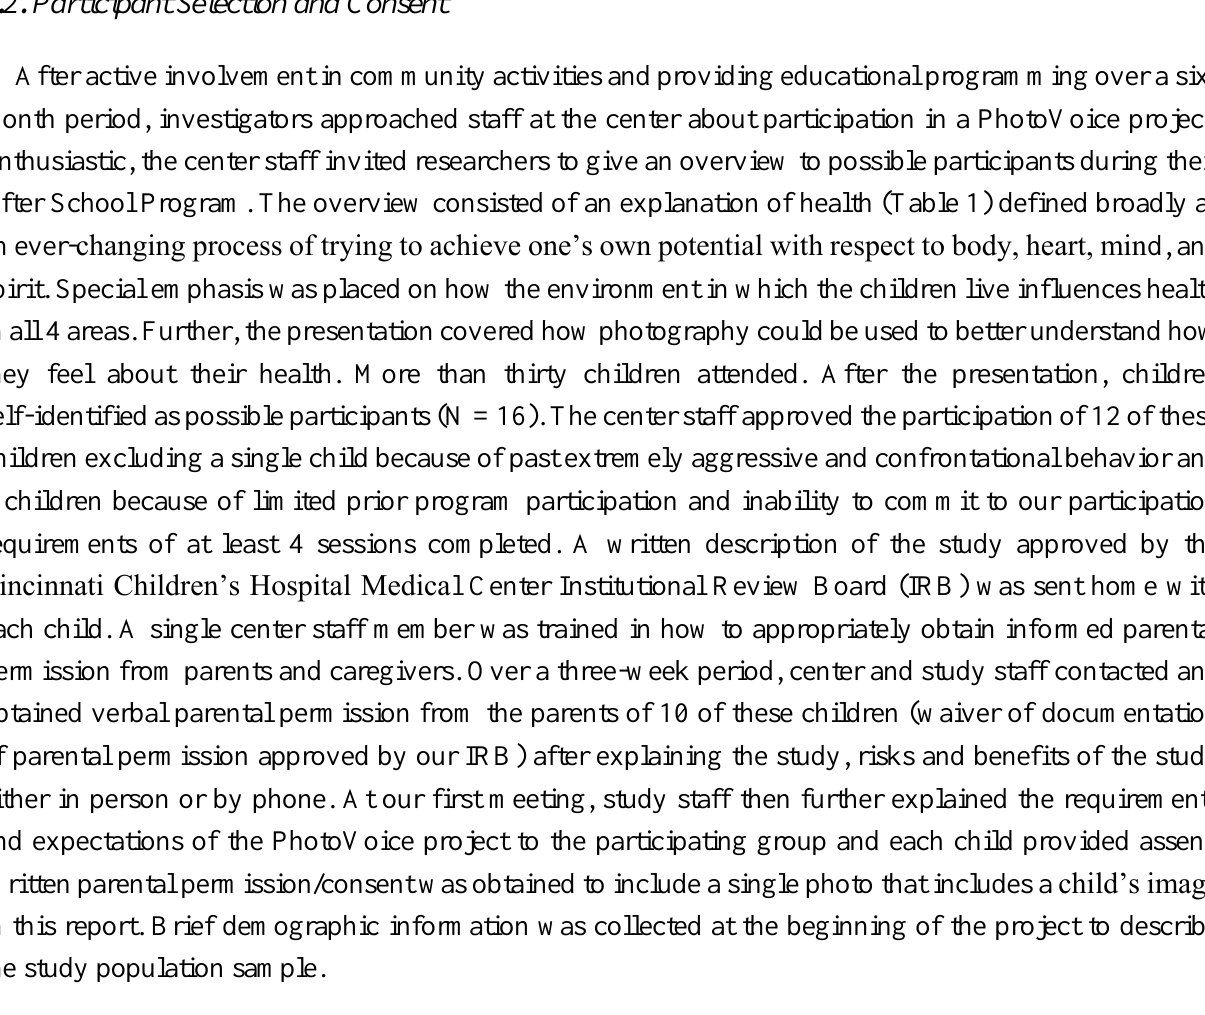
Table 1. Areas of health and PhotoVoice lessons